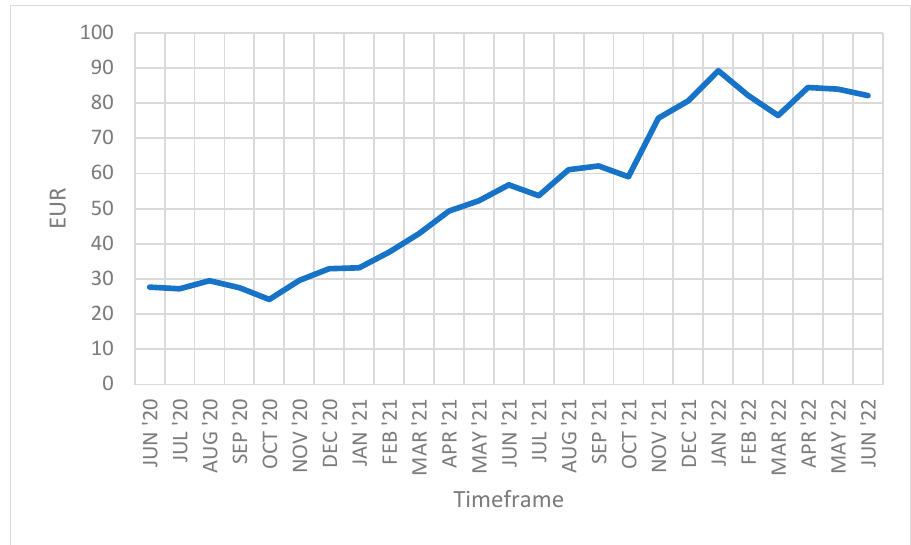
Figure 2. Timeframe for prices of EU Carbon Permits. Source: author’s own compilation based on collective monthly information from https://pl.investing.com/commodities/carbon-emissions- historical-data (accessed on 20 June 2022).